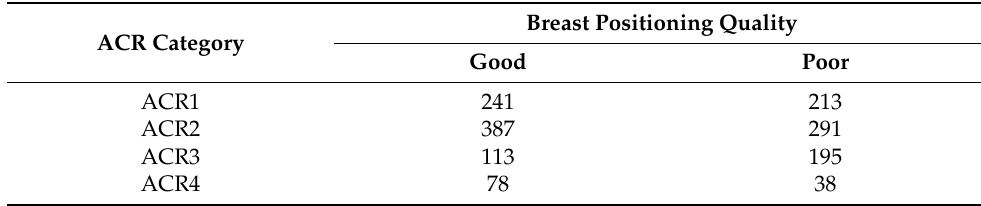
Table 1. Classification results of the collected 1556 MLO views according to ACR categories and quality of breast positioning.